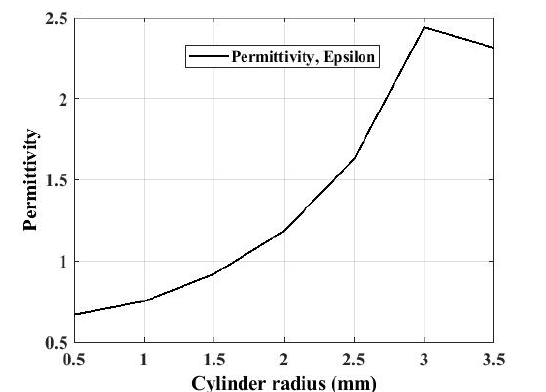
Figure 2. Relative permittivity distribution against the radius of